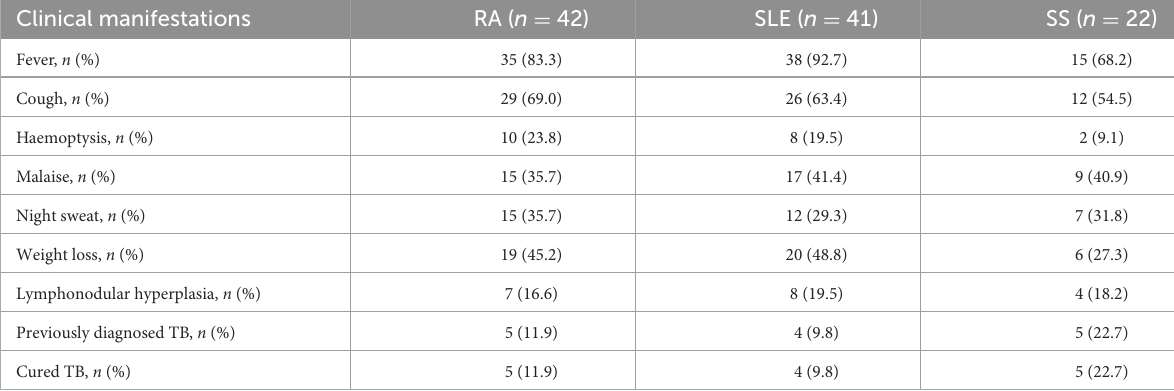
TABLE 2 Clinical manifestations in the TB group.